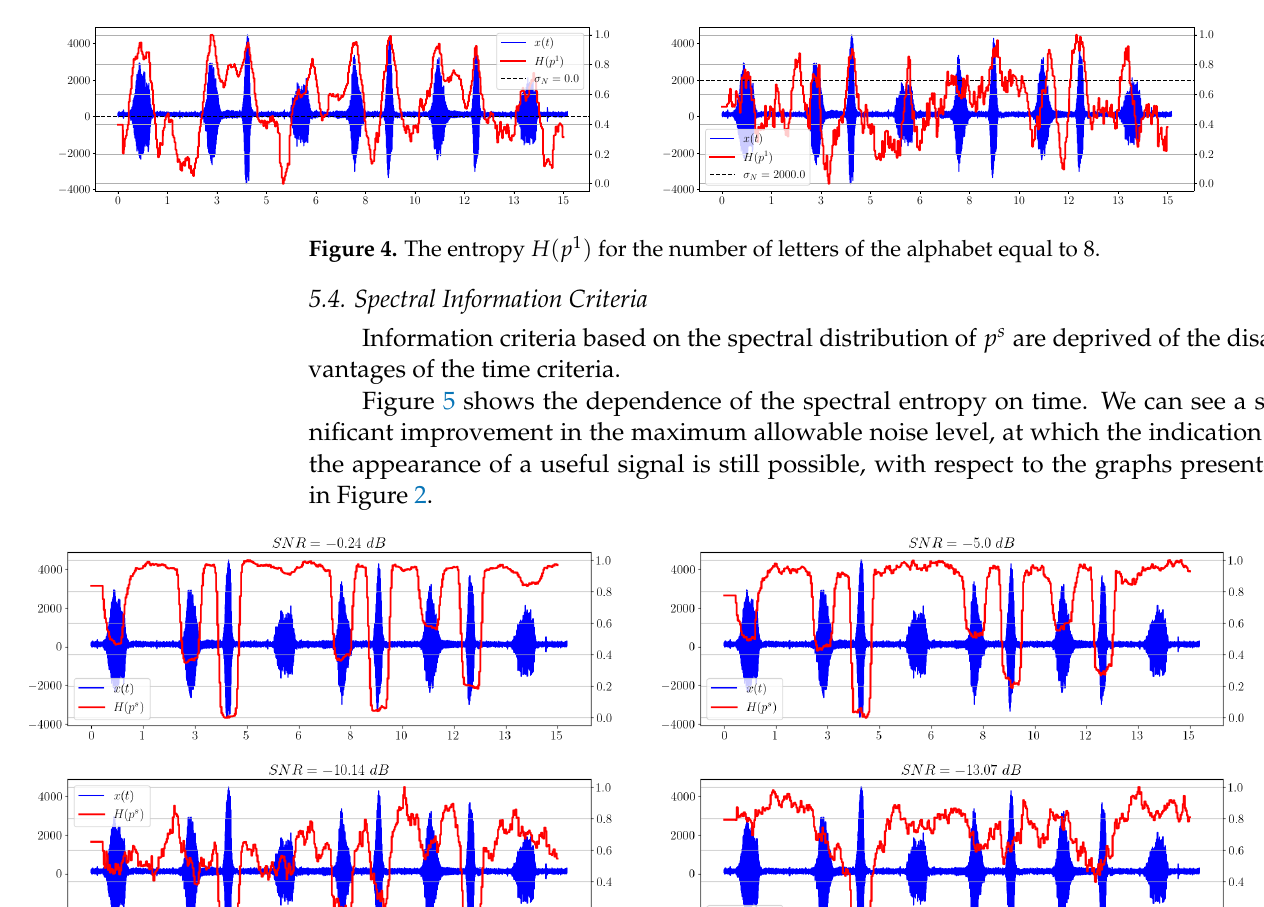
Figure 3. The entropy H ( p 1 ) for the number of letters of the alphabet equal to 64. Changing the alphabet partitioning negatively affects the effectiveness of entropy in this representation: